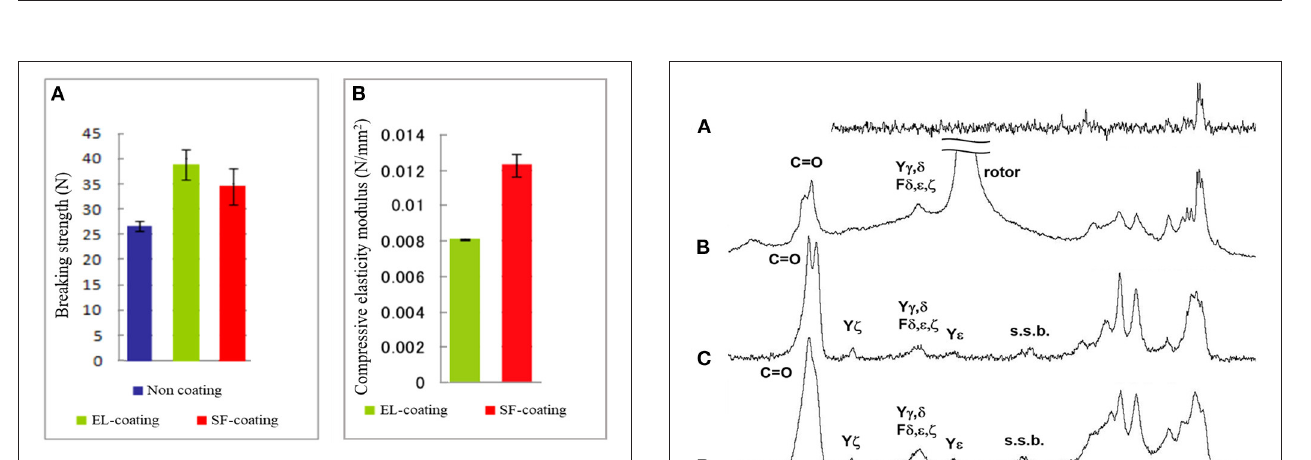
removed. The grafts were mainly covered by fat and